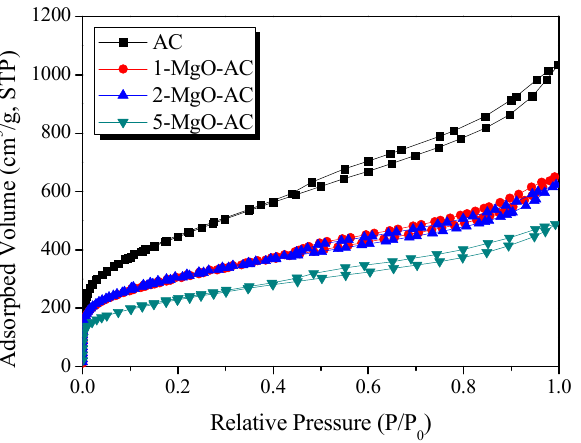
Figure 4. N 2 /77 K adsorption–desorption isotherms of AC and MgO coated ACs with different MgO loading amounts.